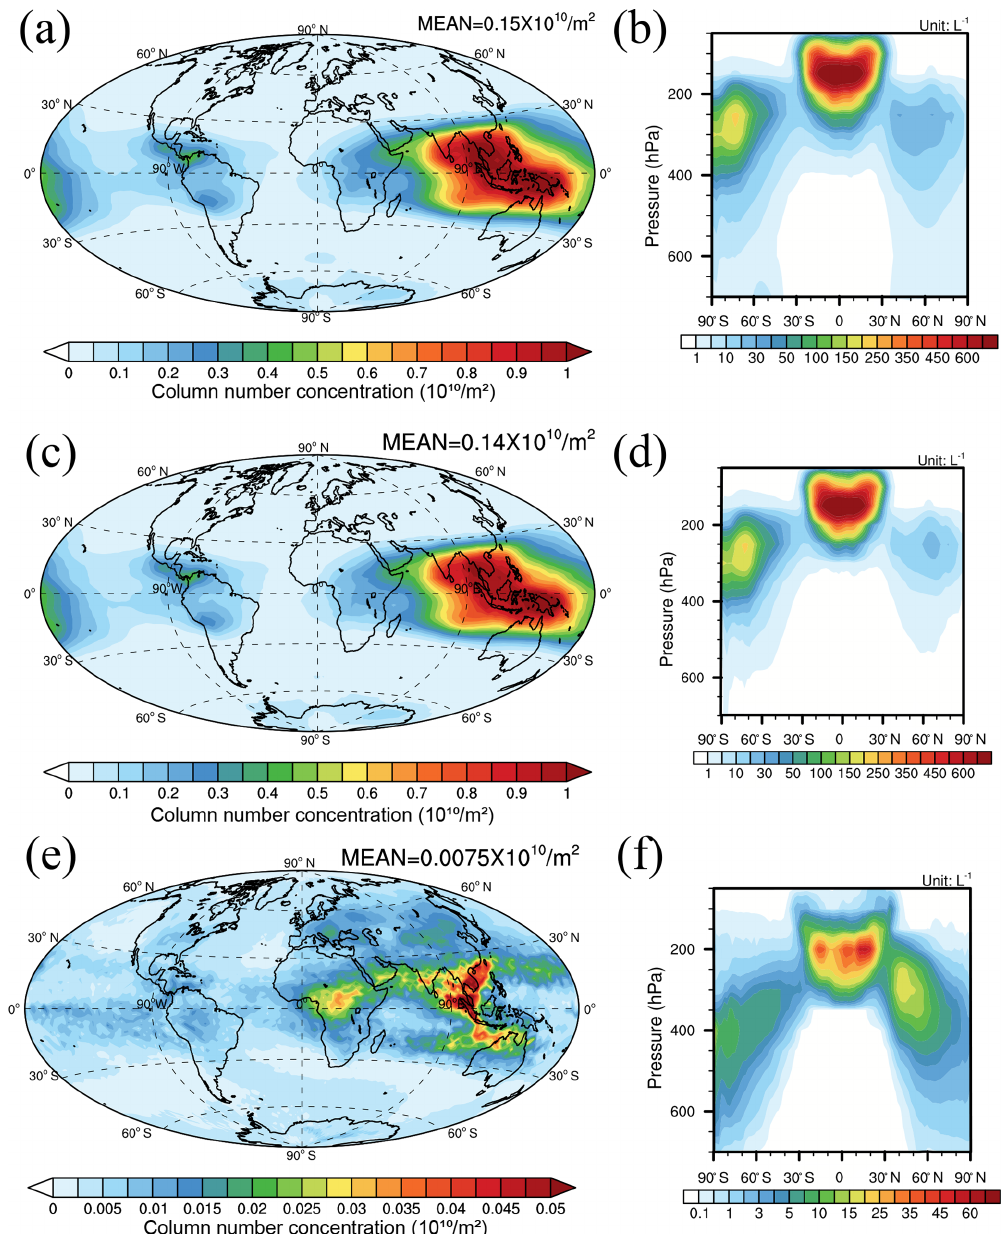
Figure 2. The vertically integrated total N i in the PD_Base case (a) , N i from homogeneous nucleation (c) , and N i from heterogeneous nucleation (e) . The zonal average plots of N i in the PD_Base case (b) , N i from homogeneous nucleation (d) , and N i from heterogeneous nucleation (f) . Note: the vertical axes in (b) , (d) , and (f) are in hybrid pressure